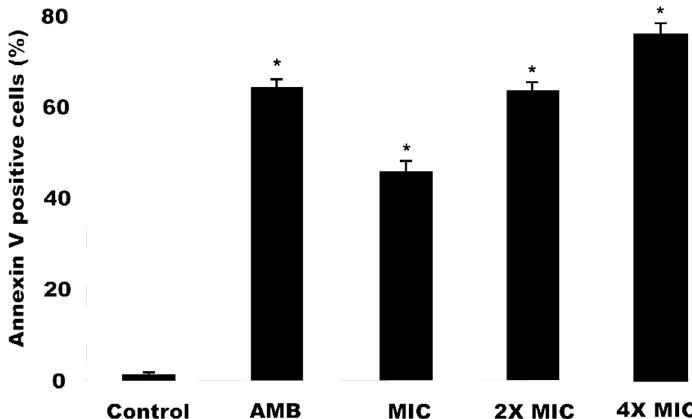
Figure 2. Effect of O. glomerata methanol extract on phosphatidylserine (PS) release in C. krusei cells. Data represent the mean and standard deviation (SD) of fluorescence during annexin-V labeling in two independent experiments with at least three replications. Analysis of variance (ANOVA) was performed followed by the Student-Newman-Keuls test ( p < 0.05). * indicates significant differences between the percentage of fluorescence intensity of annexin-V label ( p ≤ 0.05). AMB, Amphotericin B; MIC, Minimum Inhibitory Concentration; 2MIC, Double the MIC value; 4MIC, Four times the MIC value.